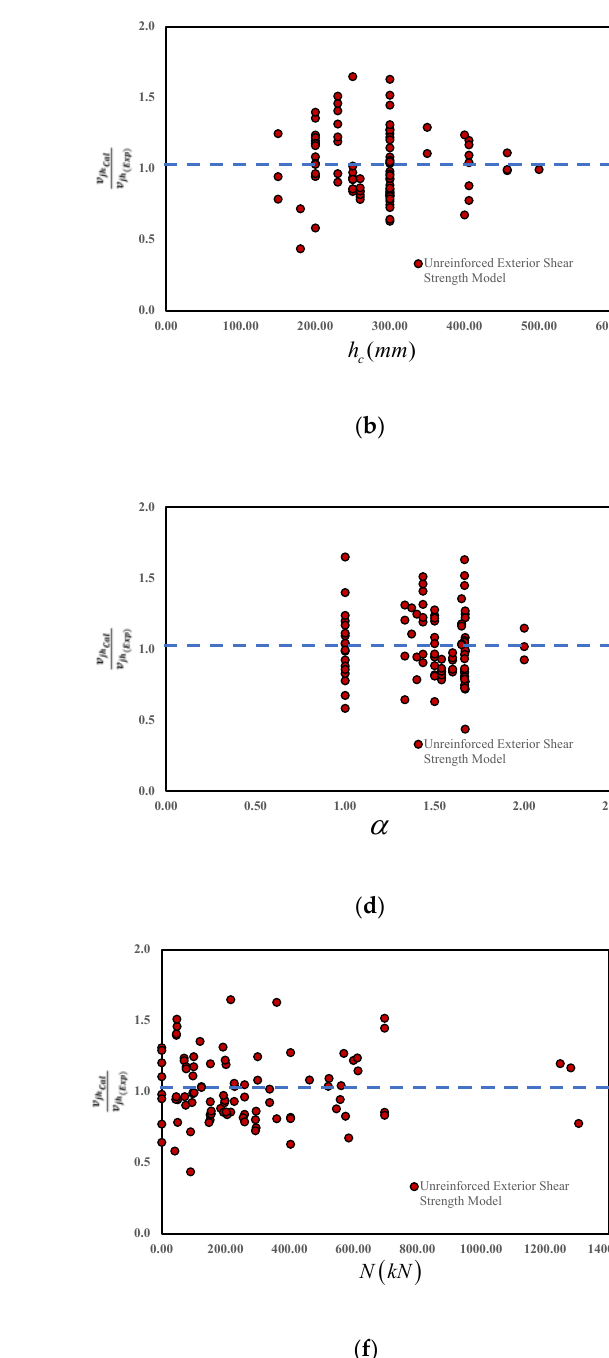
Figure 7. The predictive performance of the proposed unreinforced joint shear strength model based on the main parameters. ( a ) Concrete compressive Strength ( b ) Column Depth ( c ) Joint Width ( d ) Joint aspect ratio ( e ) Beam longitudinal reinforcement ratio ( f ) Joint Axial Load.